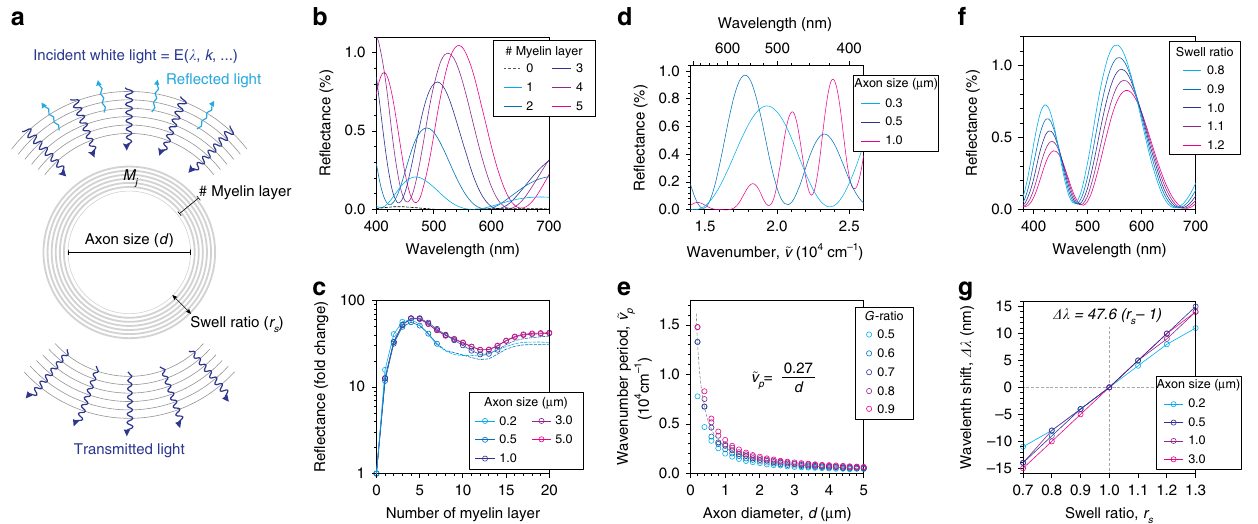
Fig. 2 Theoretical background on SpeRe. a Scheme of optic simulation for SpeRe. Structural variables of interest in myelinated axons are annotated. Absolute re fl ectance (%) for each wavelength is simulated by applying the theory of electromagnetic waves. b Simulated re fl ectance spectra with variable myelin layers. The axon size is set to 0.5 μ m. c Fold increase in visible re fl ectance (400 – 700 nm) relative to unmyelinated condition. d Simulated re fl ectance spectra with varying axon size. Horizontal axis shows the wavenumber, ~ ν (inverse of wavelength). The g -ratio (i.e., the ratio of inner axonal (cid:1) (cid:3) diameter to the total outer diameter) is set to 0.7. e Relationship between wavenumber period ~ ν p and axon diameter (d ). Dotted line indicates fi tted curve to hyperbola ( R 2 = 0.99), and the best- fi t equation is shown. f Simulated re fl ectance spectra with a varying swelling ratio of the extracellular space between the myelin layers. The axon size and g -ratio at the isosmotic condition are set to 0.5 μ m and 0.7 (i.e., 6 myelin layers), respectively. g The relationship between spectral shift ( Δ λ ) and swelling ratio ( r s ). The equation is the best fi t to linear regression ( R 2 =